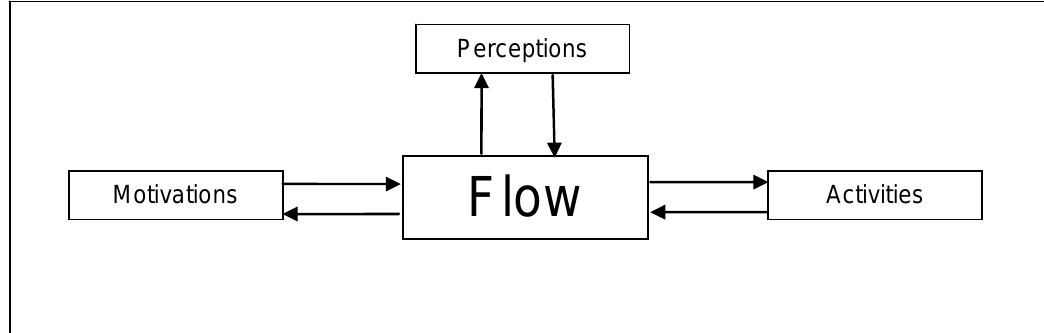
Figure 3: The dynamic nature of flow The dynamic nature of flow is an interactive, two-way mechanism in which each construct is operated upon by it and in turn affects it. Each construct also affects the other (see Figure 1) and so there is a continually changing